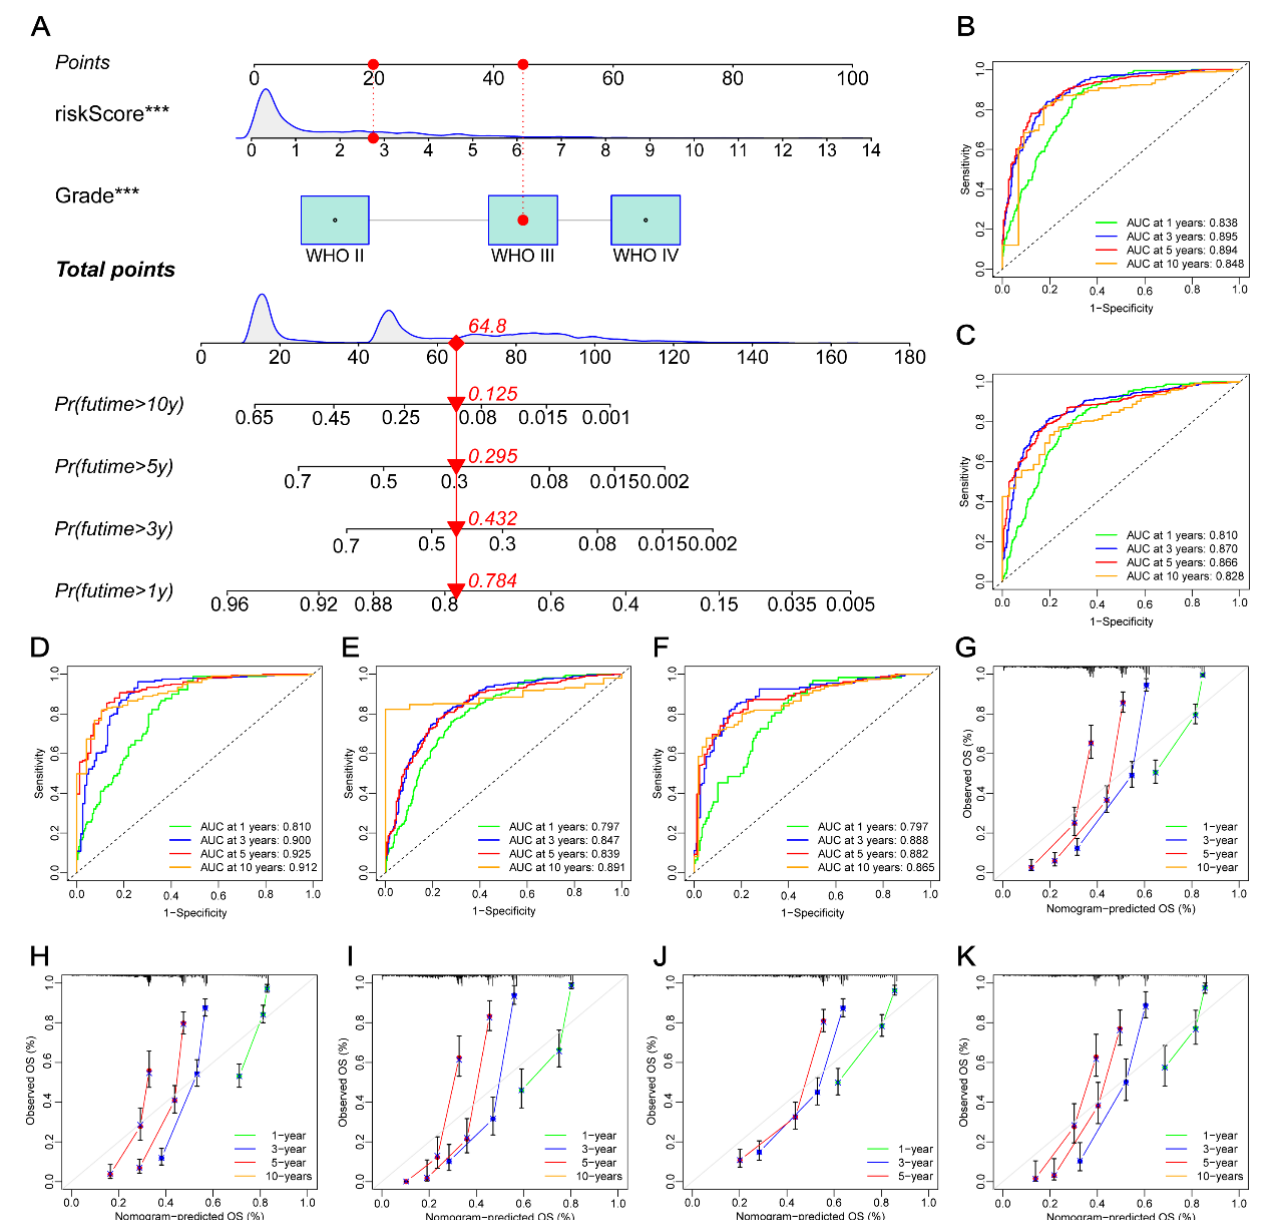
Figure 8. Development and verification of our nomogram. ( A ) Nomogram in glioma patients for assessing the 1-, 3-, 5-, and 10-year OS in the training dataset. ( B – F ) ROC curves of 1-, 3-, 5-, and 10-year in the training, testing, CGGA mRNAseq_325, mRnaseq_693, and microarray datasets. ( G – K ) Calibration curves of 1-, 3-, 5-, and 10-year in the training, testing, CGGA mRNAseq_325, mRnaseq_693, and microarray datasets. ***, p < 0.001; OS, overall survival; ROC, receiver operating characteristic; CGGA, the China Glioma Atlas.